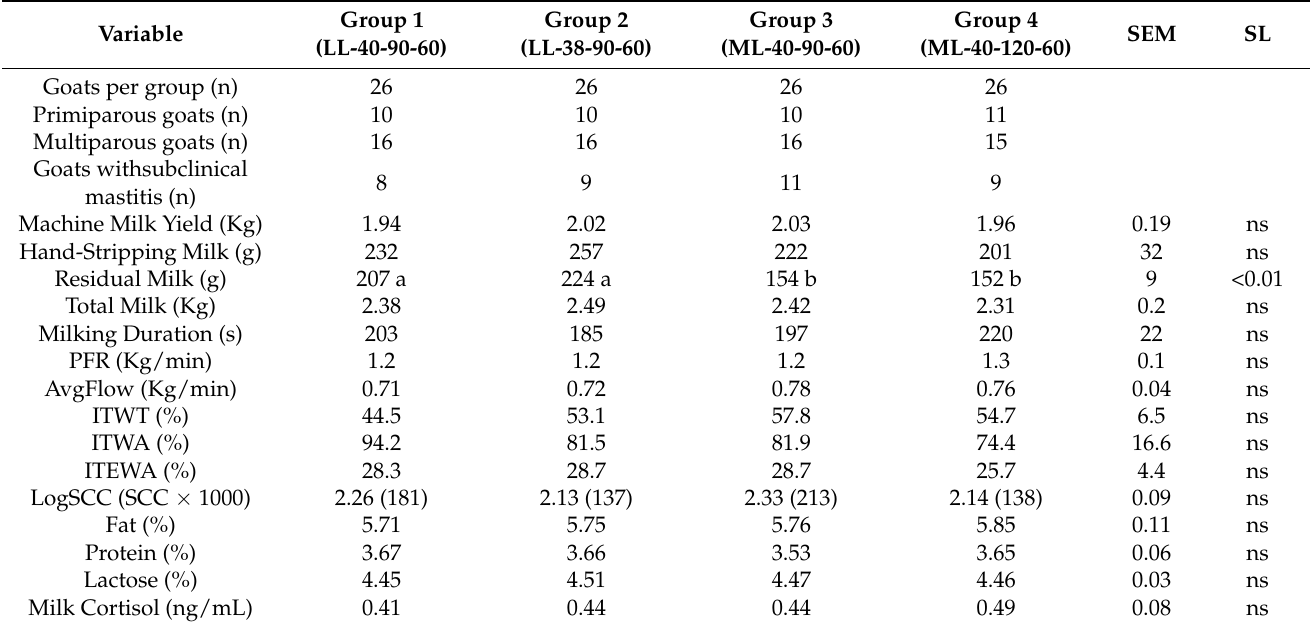
Table 1. Characteristics of the four groups of goats included at the beginning of the experiments (means ± standard